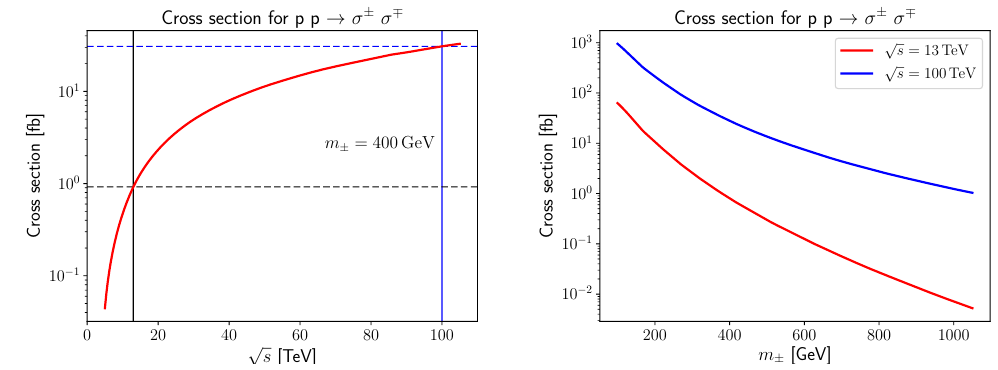
Figure 6 . Cross section (cid:27) prod for pair production of charged scalars (cid:27) (cid:6) . The left panel shows the increase of (cid:27) prod for larger center of mass energies and (cid:12)xed scalar mass. The black (blue) vertical lines indicate the energy range of HL-LHC (FCC-hh) while dashed lines correspond to the respective cross section. In the right panel we show (cid:27) prod for di(cid:11)erent scalar masses and (cid:12)xed energy. By increasing m the cross section drops signi(cid:12)cantly. (cid:6) for a fast detector simulation. By using these tools, we were able to reproduce the results given in [55, TABLE I. Results on the non-SM contribution in the Di-tau + (cid:26)(cid:26) E TABLE I. Results on the non-SM contribution in the Di-tau + (cid:26)(cid:26) E σ ( p p